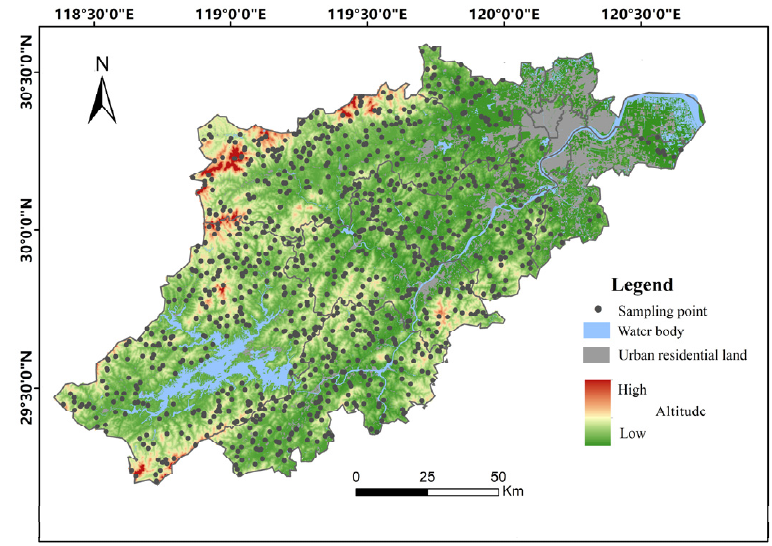
Figure 5. Sample point distribution map.